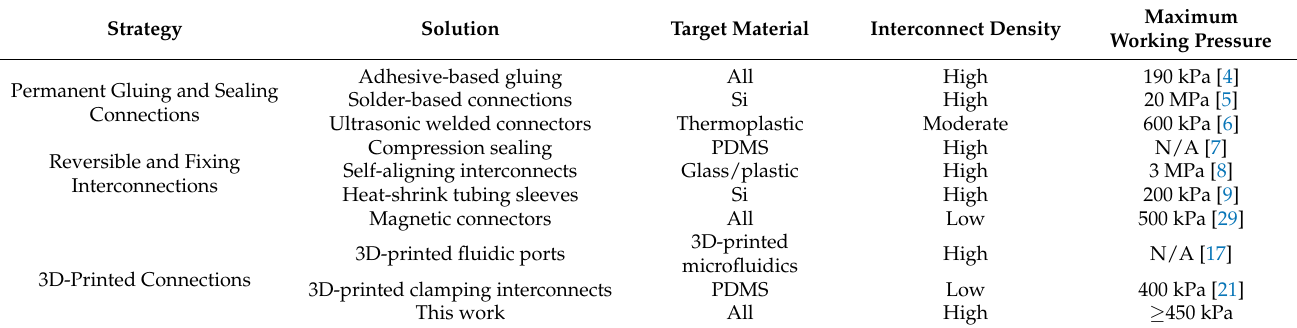
Table 1. Benchmarking of 3D-printed connectors in this work with other microfluidic interconnections. Strategy Solution Target